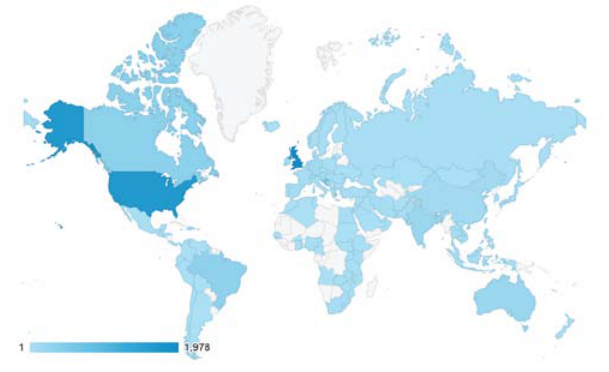
Figure 2. Journal's global impact: in the 18 months